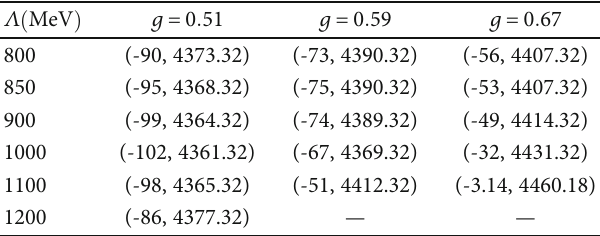
ð 4380 Þ and g c